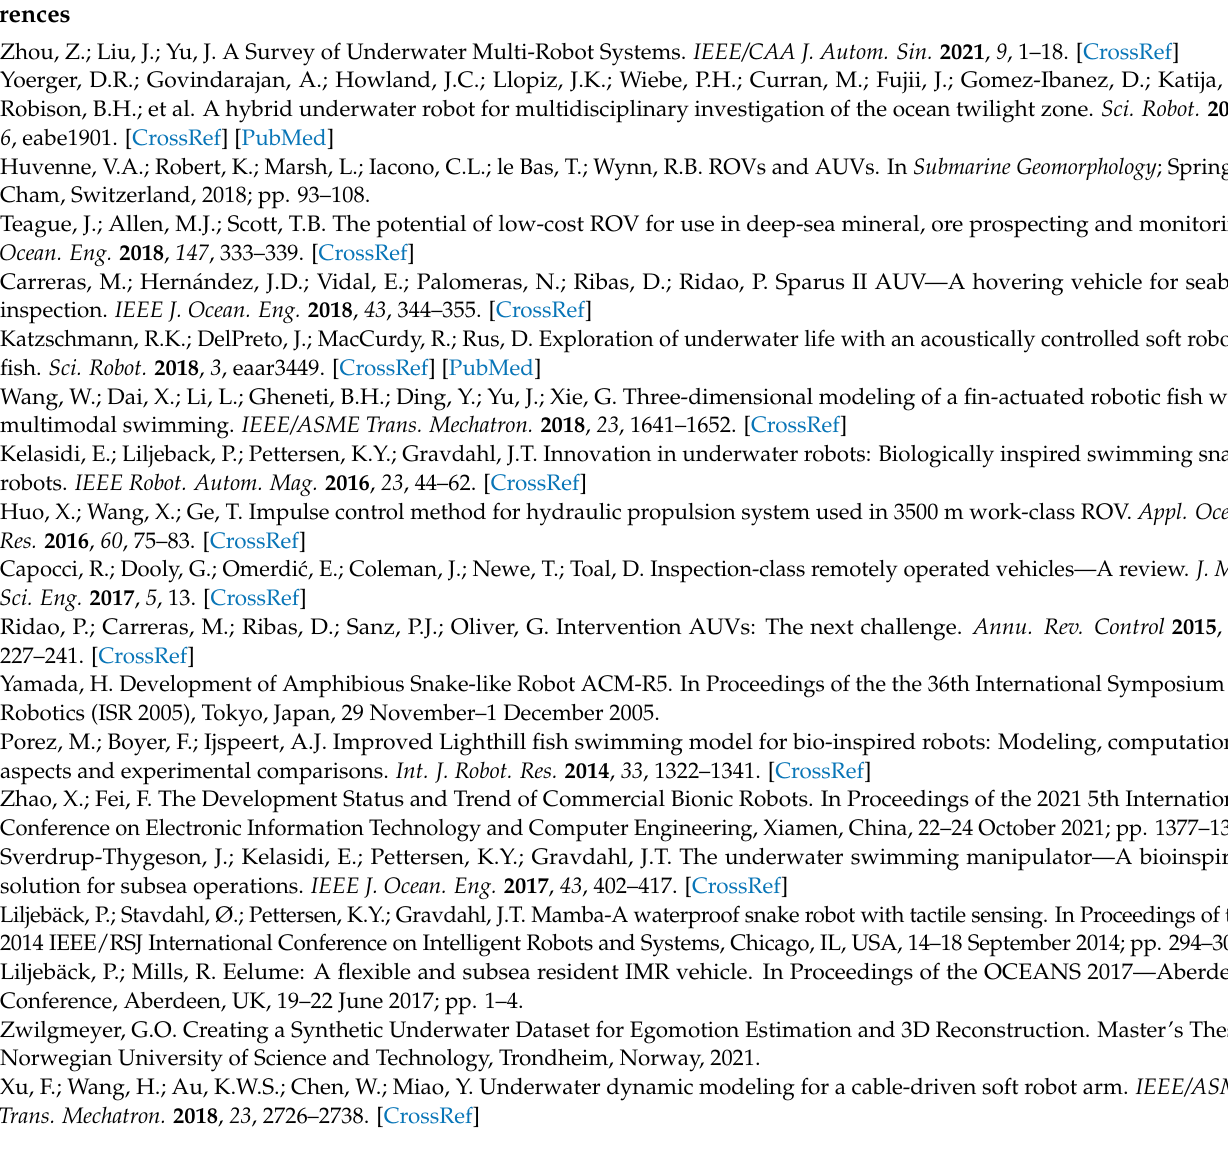
Figure A2. Simulation tests of comparison of turning performance, (a) in a straight state and (b) bending state.